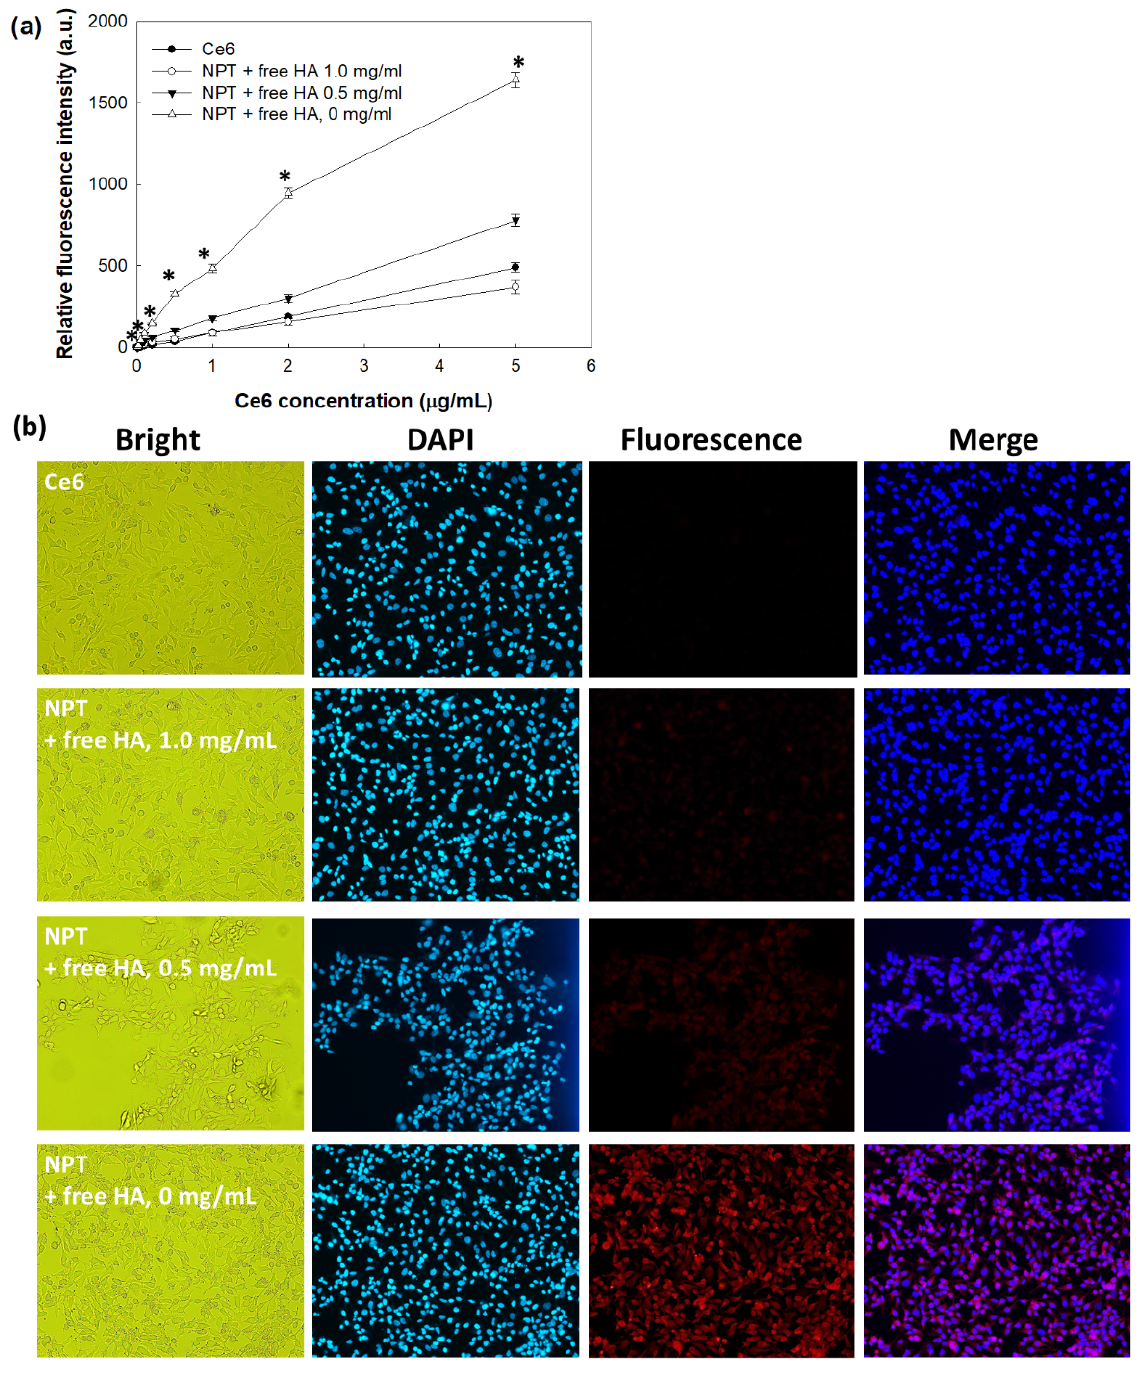
Figure 5. Ce6 uptake ratio of HeLa cells. ( a ) HA pretreatment effect on the Ce6 uptake